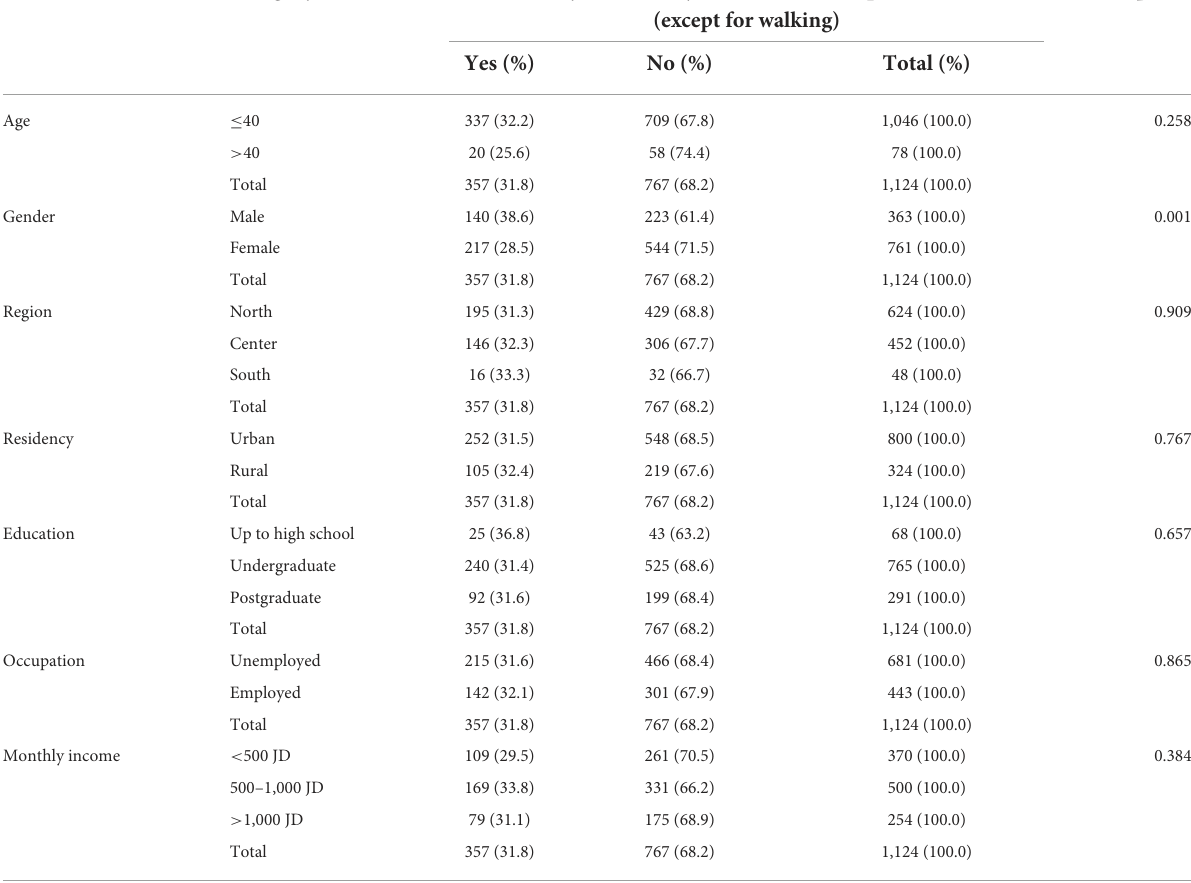
TABLE 1 Distribution of socio-demographic variables by physical activity at least 2 times per week ( N = 1,124).